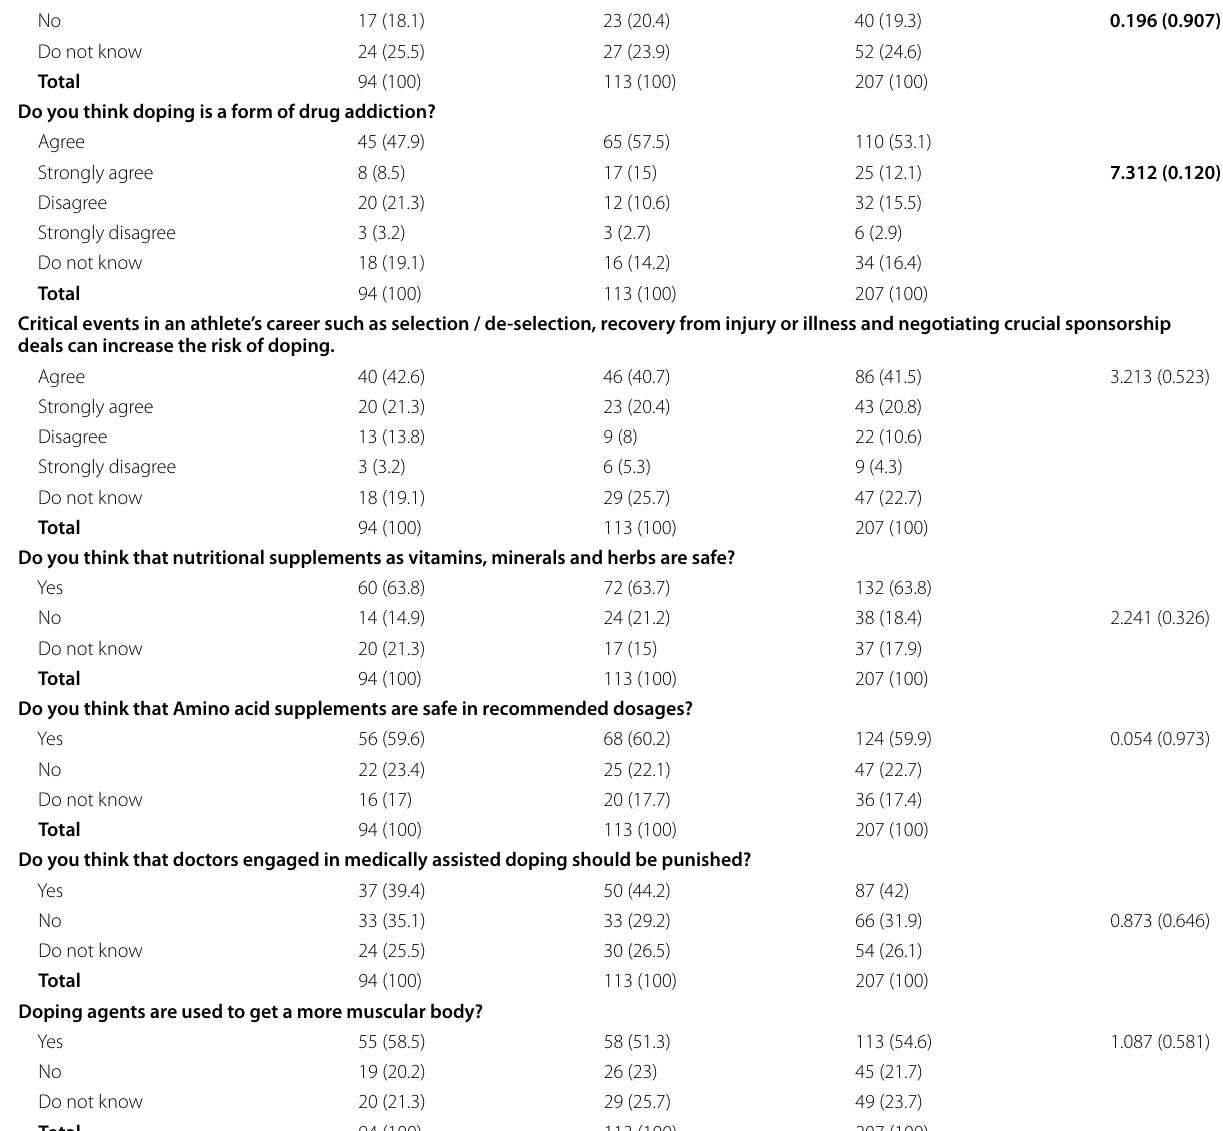
Person chi-square test